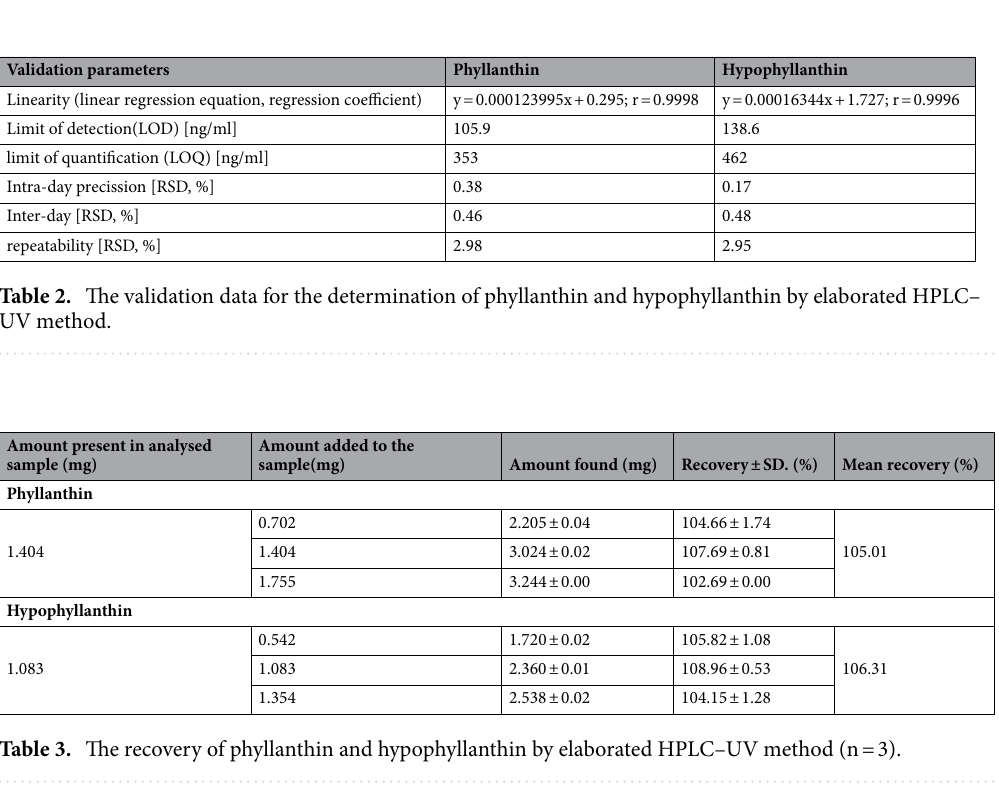
Table 3. The recovery of phyllanthin and hypophyllanthin by elaborated HPLC–UV method (n = 3).